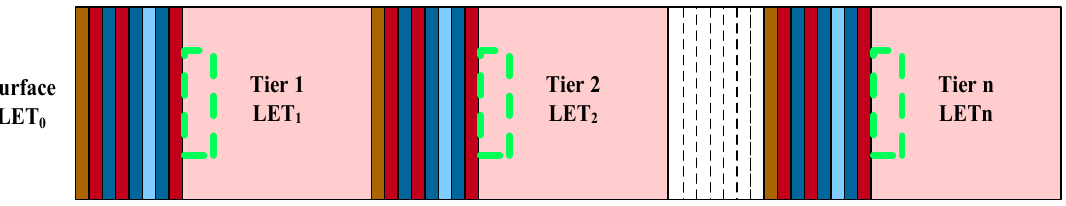
Figure 5. Cross-section schematic of three-dimensional (3D) stacked device and the corresponding marked LET.